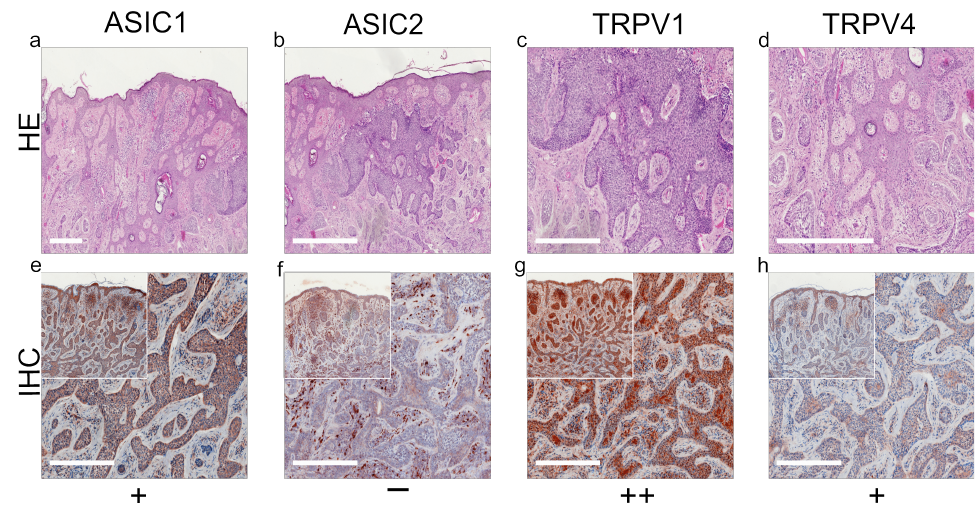
Figure 2. Immunohistochemistry of BCC. Immunohistochemical staining for ASIC1, ASIC2, TRPV1 and TRPV4 in BCC tissue. ( a – d ) H&E staining, ( e – h ) immunohistochemical staining, inserted smaller pictures give an overview. Scale bars represent 200 µm. ( a – h ) Patient 10. This BCC shows a strong expression of ASIC1 and TRPV1. The expression of TRPV4 is weak and positive, but this BCC shows no expression of ASIC2. For more stainings of other BCCs, see Supplementary Figures S4–S7.